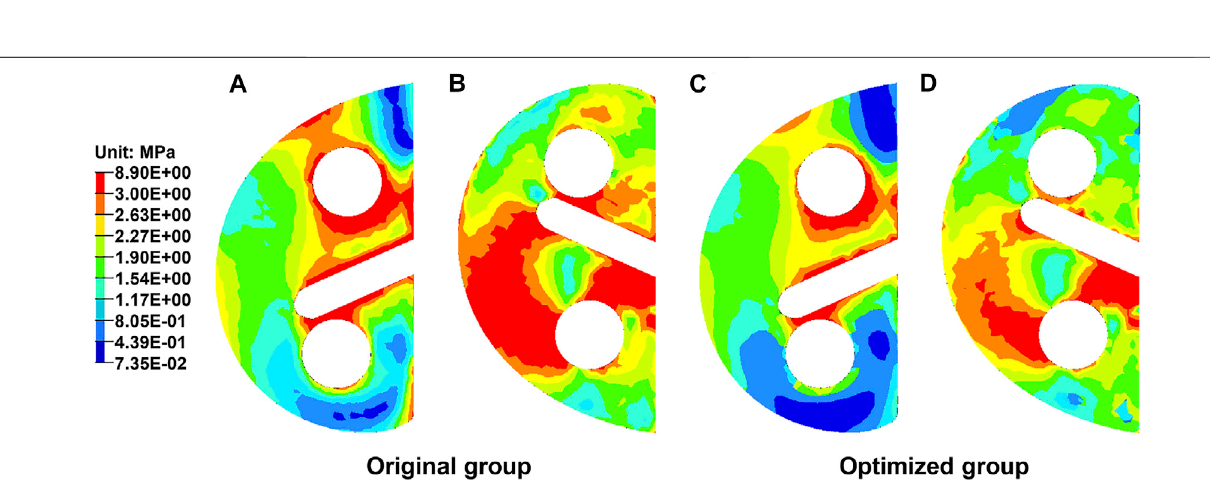
Frontiers in Bioengineering and Biotechnology |